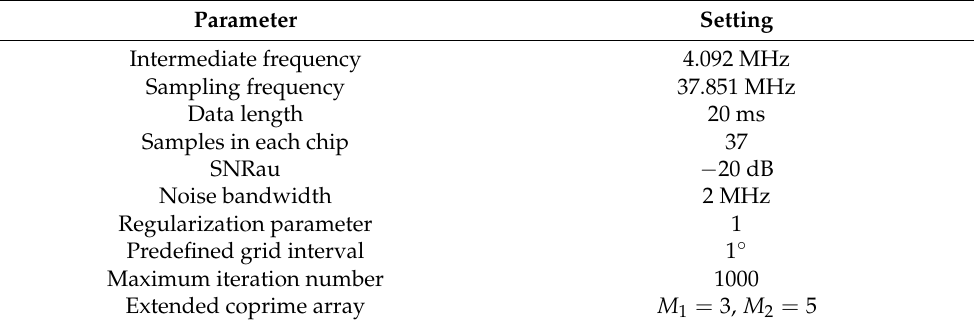
Table 1. Summary for simulation